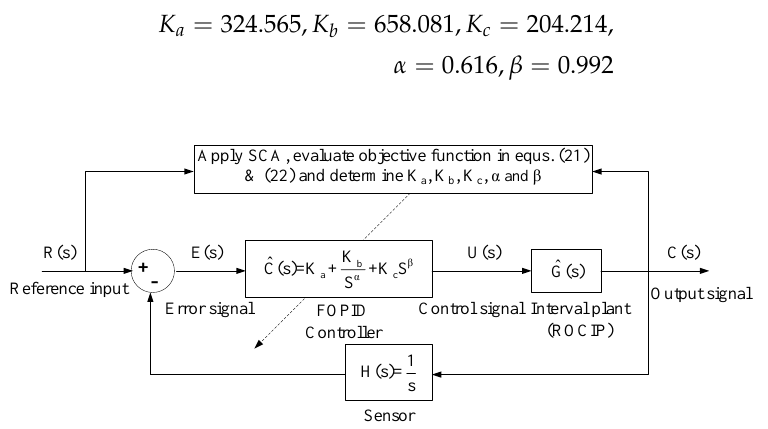
Figure 9. ROCIP with an SCA-based FOPID